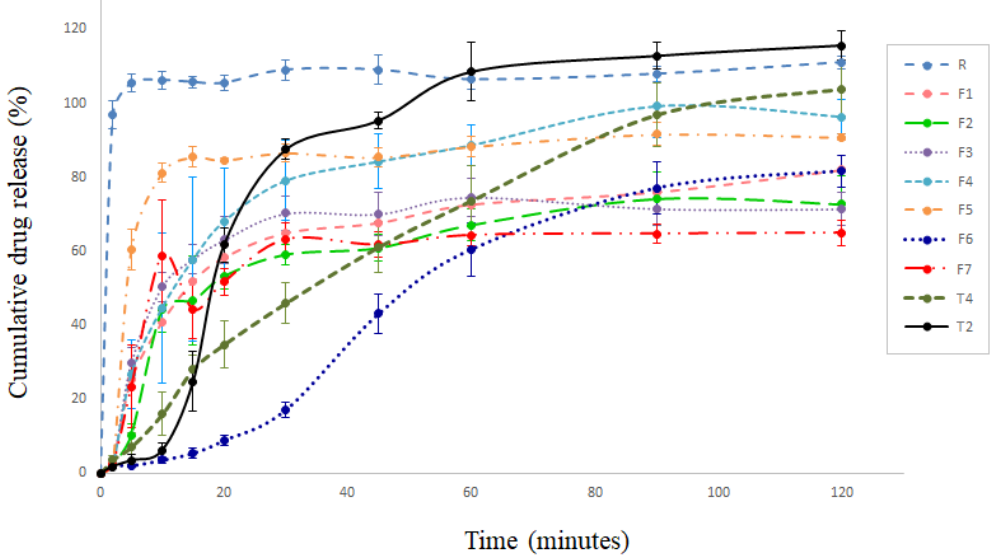
FIGURE 3 – Dissolution profile (n = 6) for the capsules (P1, P2, P3, P4, P5, P6, P7, T2 and T4) and tablets (R) of